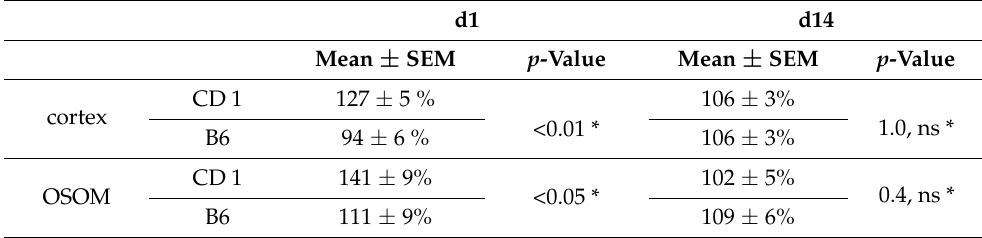
Figure 2. T2-values, representing tissue edema, were significantly more pronounced in CD1- mice on d1 after IRI. T2 maps were analysed to quantify tissue edema and relative T2-values were cal-culated as the percentage of T2-values of the ischemic and the control kidney (the con-tralateral, non-ischemic kidney on d1 served as control). For the comparison of rela-tive T2-values of the two mouse strains, unpaired t -tests (due to gaussian distribution of data) were performed. Relative T2-values of B6-mice ( n = 5, black dots) and CD1-mice ( n = 5, grey squares) are presented in dotplot diagrams with mean and standard devia-tion. T2-values were significantly higher in CD 1-mice on d1 in the renal cortex and OSOM compared to B6-mice, reflecting more pronounced tissue edema in these layers. No significant differences in tissue water content were found on d14 when using T2 mapping. IRI = ischemia reperfusion injury, * = p < 0.05, ** = p < 0.01. Table 2. Relative values of T2 maps at d 1 and d14 after 35 min